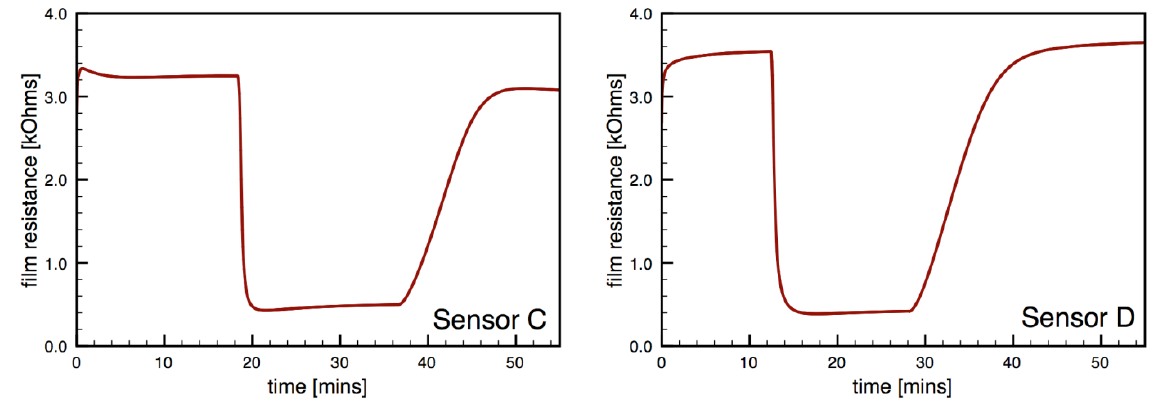
Figure 7. Sensor performance for localized gold additives; sensor architectures C and